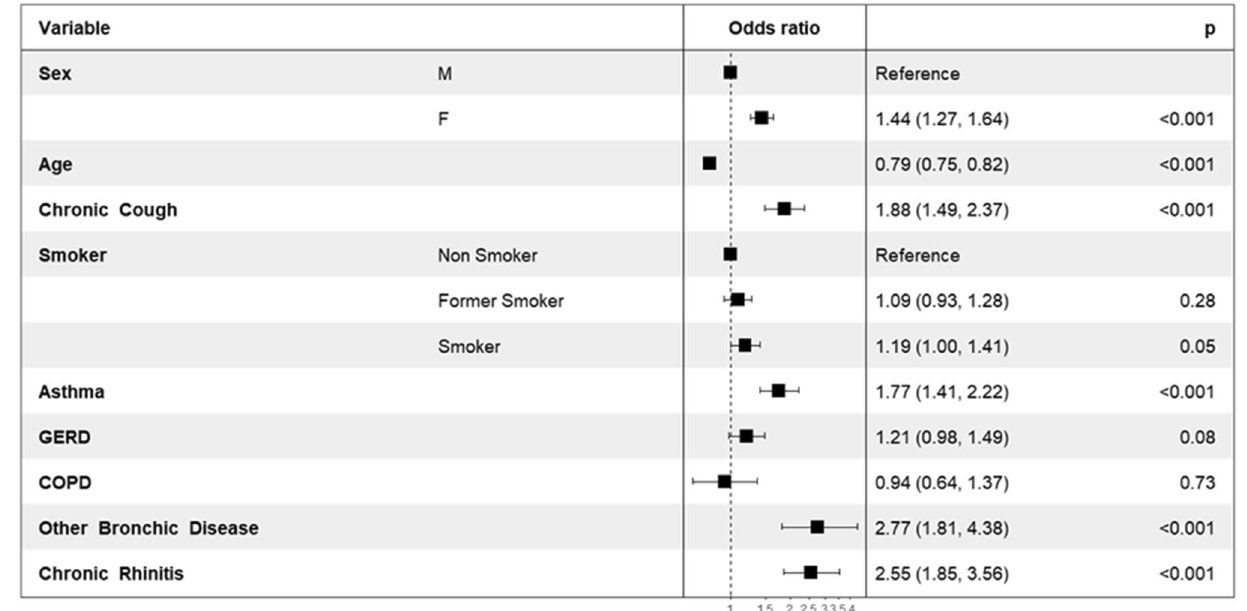
Figure 2. Multivariate analysis in subjects with sensitive